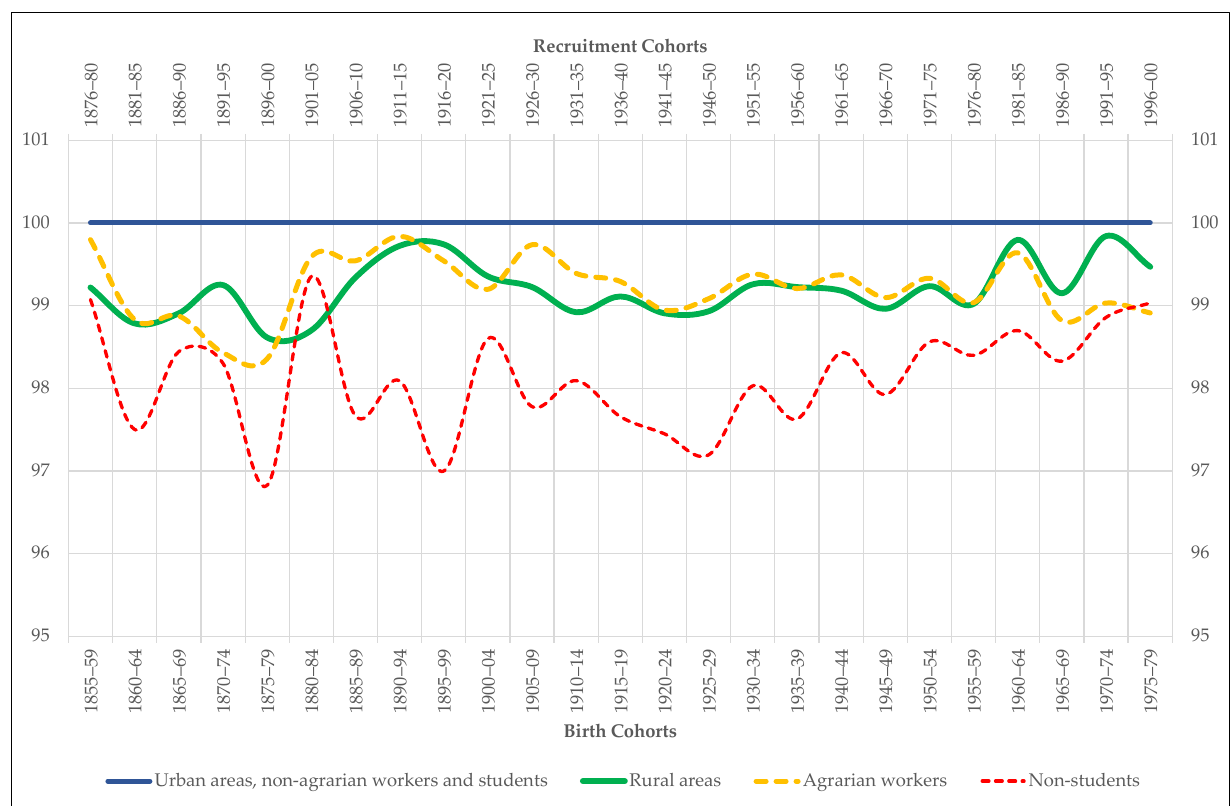
Figure 5. Mean height of the recruits included in the sample Extremadura by place of residence, occupation, and socio- educational status (urban areas, non-agrarian workers and students =